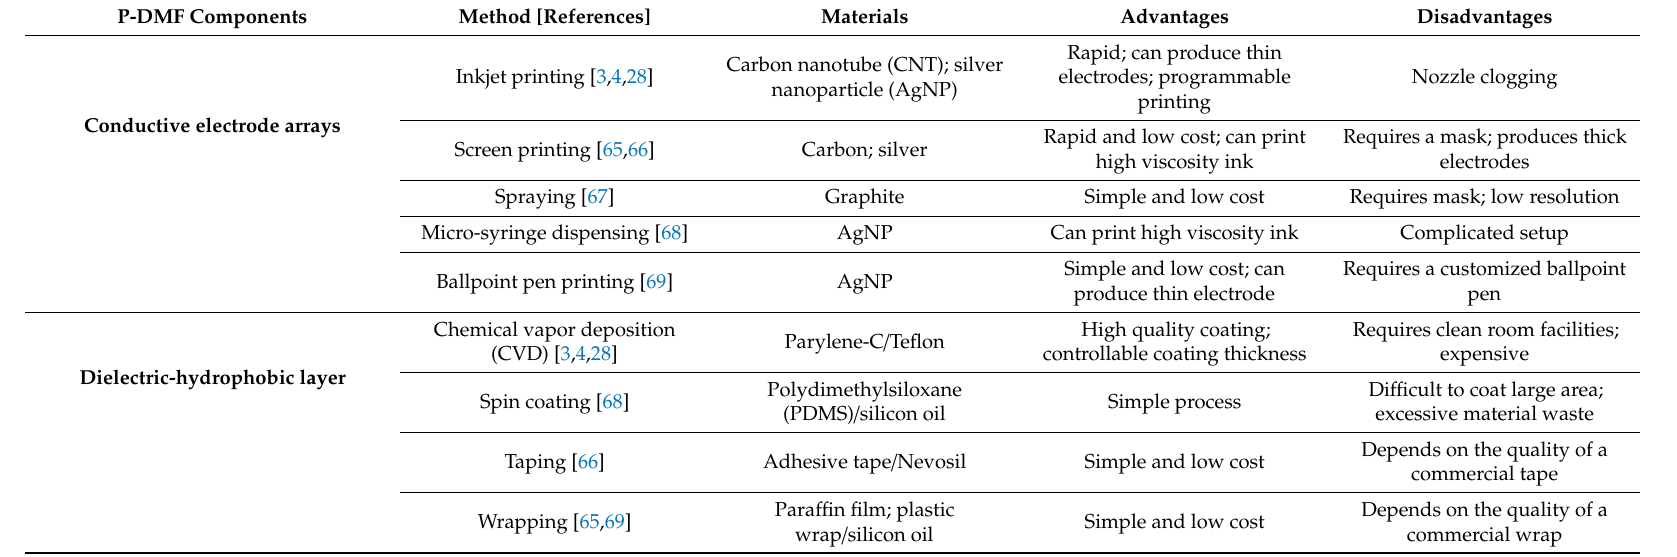
Table 2. Summary of published fabrication methods, materials, advantages, and disadvantages of p-DMF